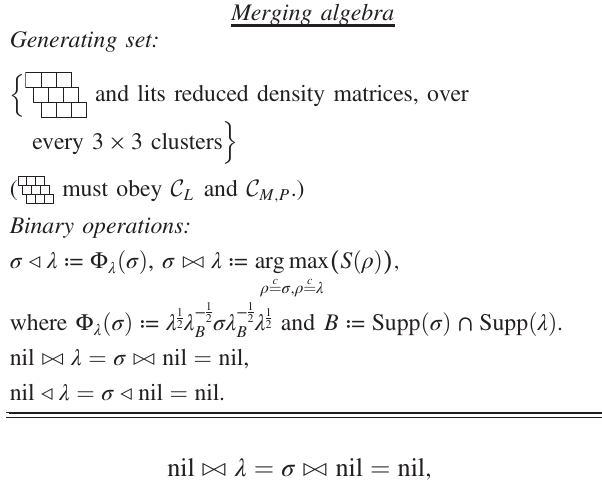
TABLE II. Merging algebra. Merging algebra Generating set: n and lits reduced density matrices, over o every 3 × 3 clusters must obey C L and C M;P